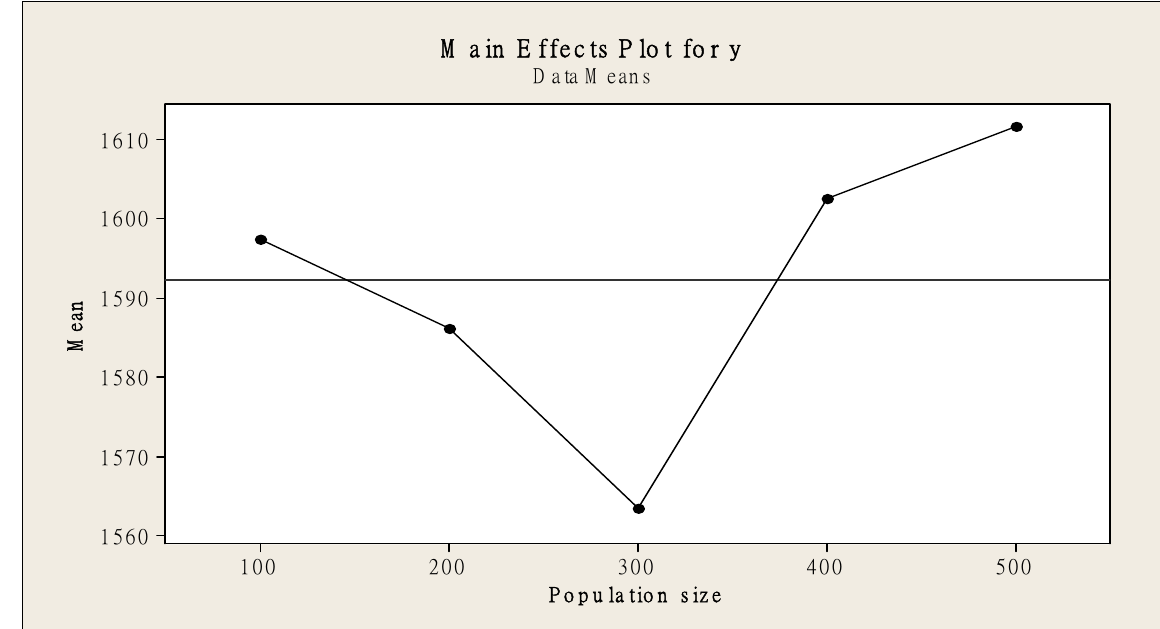
Figure 10. The mean plot of population size for a one ‐ factor factorial design.